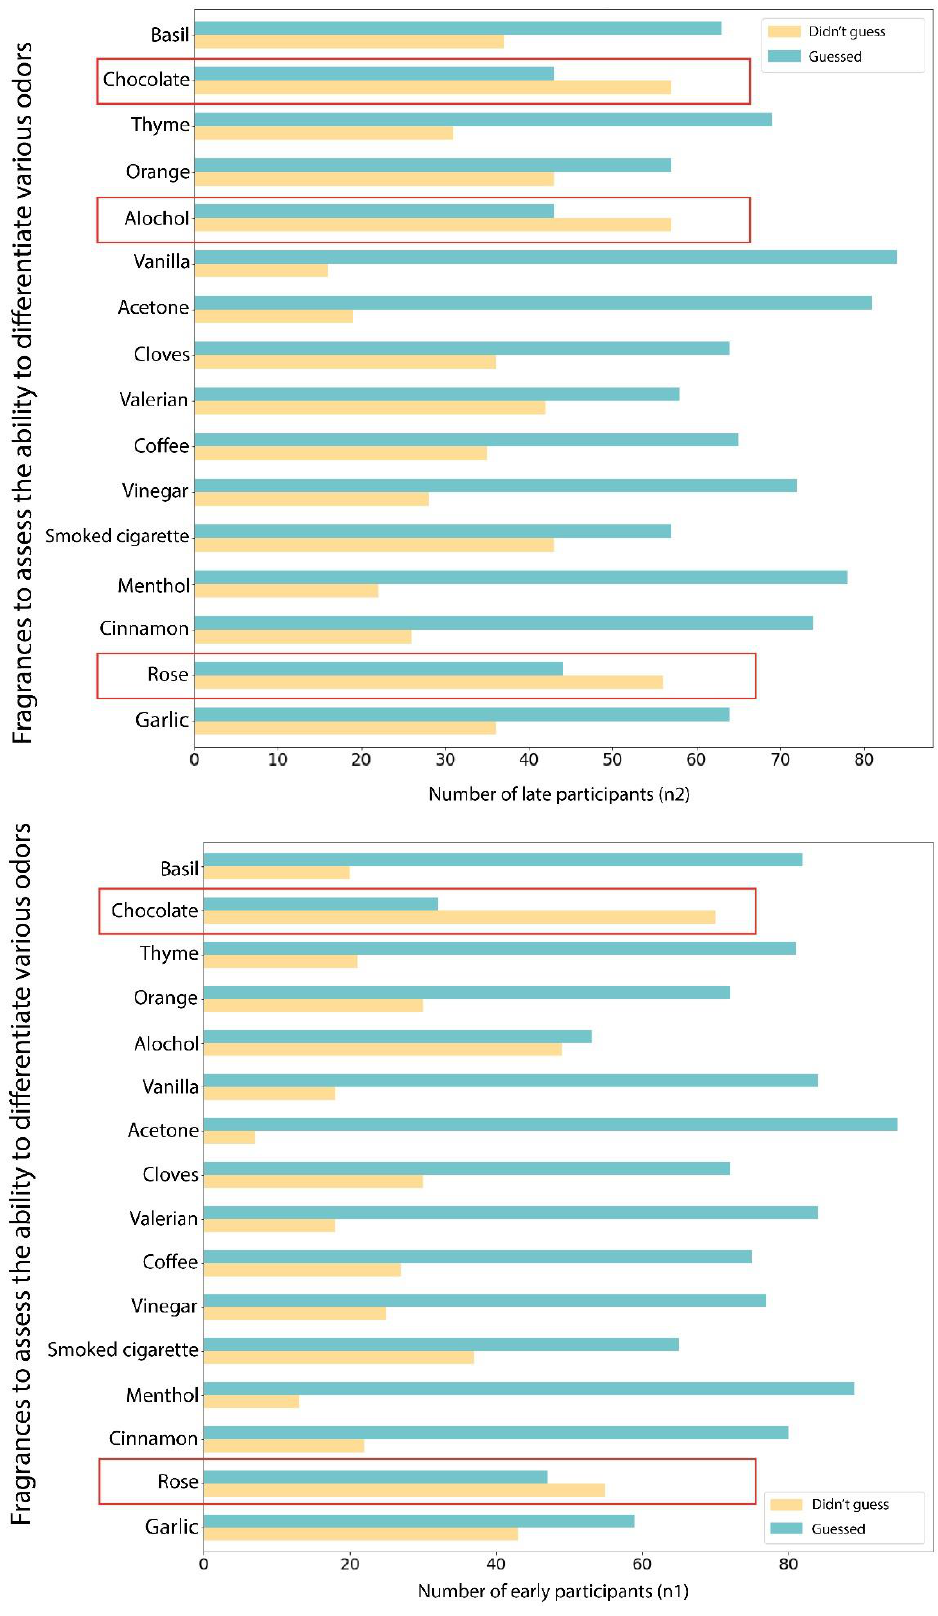
Figure 6. The differences in the ability to differentiate various odors among the participants of the early and late groups. The red boxes highlight fragrances with contrasting results.